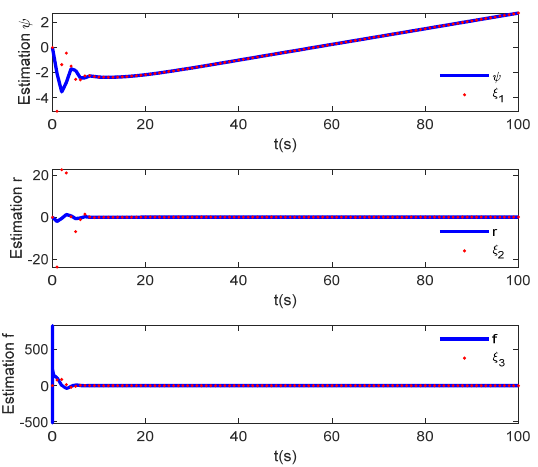
Figure 7. The estimation with ESO in curved-line path following.